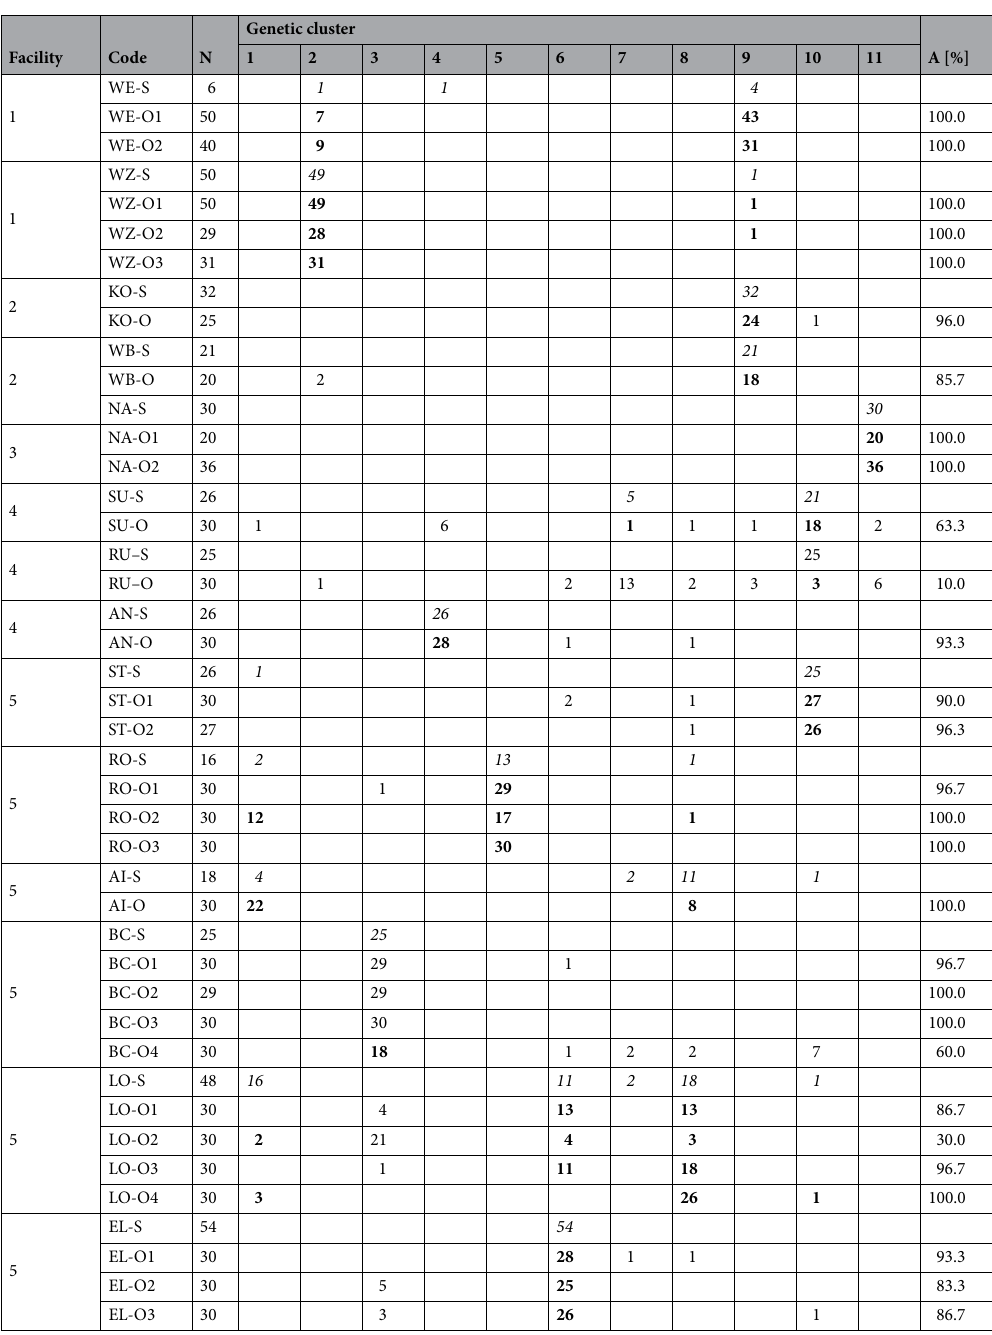
Table 2. Assignment of 1300 Margaritifera margaritifera individuals to genetic clusters identified based on genotyping nine polymorphic microsatellite markers and individual membership coefficients derived from Structure and Clumpp software. Individuals were derived from 14 source populations (S) and corresponding offspring cohorts (O) propagated at five different European breeding facilities. Genetic clusters present in source populations are highlighted in italic. Bold numbers refer to the number of samples in offspring cohorts belonging to the same genetic cluster(s) as the corresponding source population, regular numbers refer to the number of samples belonging to a genetic cluster not represented in the source population. Dashed lines delimit corresponding parental populations and offspring cohorts. N = number of analyzed samples, A = percentage of propagated individuals assigned to a genetic cluster represented in the corresponding source